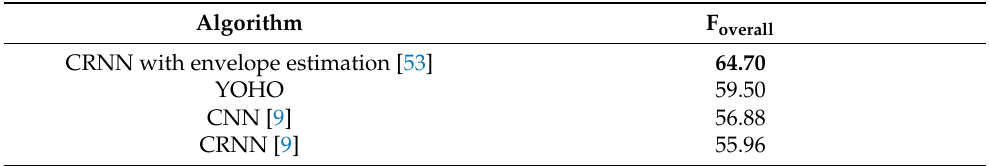
Table 8. Segment-based overall F-measure on the Urban-SED dataset. The value in bold indicates the algorithm with the highest